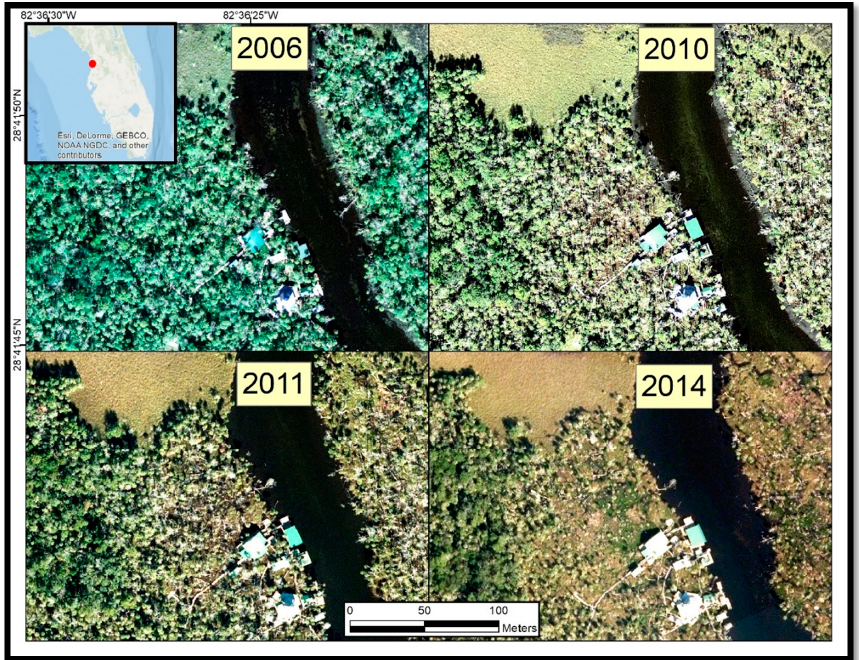
Figure 3. Aerial photographs from 2009, 2010, 2011, and 2014 of a tributary along the Chassahowitzka River appear to show substantial loss of coastal forest adjacent to the waterway.